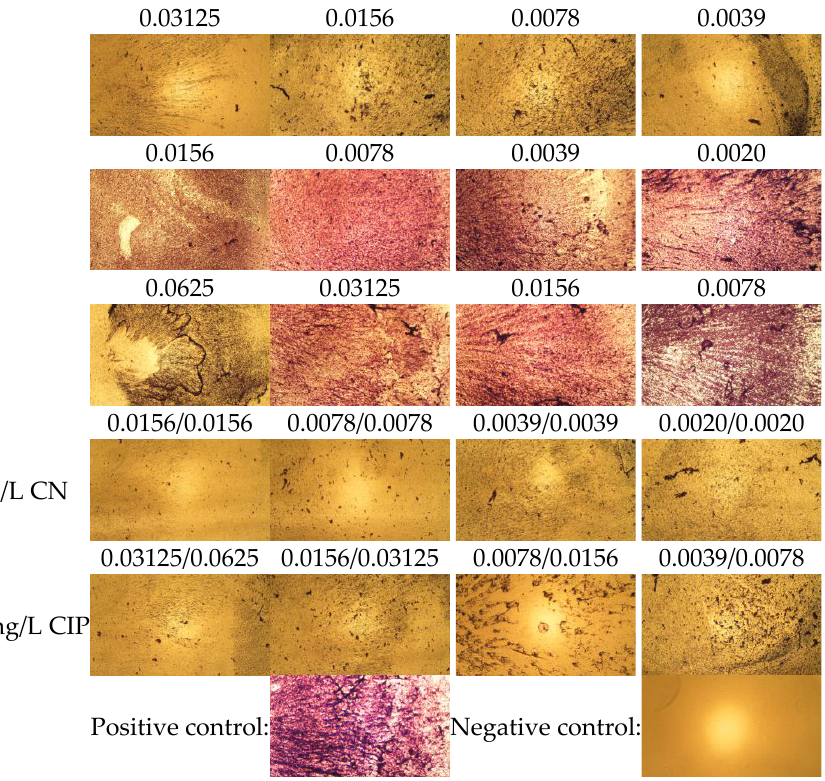
Figure 7. Biofilm formation after treatment of MRSA with OrO-NP, gentamicin and ciprofloxacin and the synergistic combinations in hydrogels (magnification 40×).